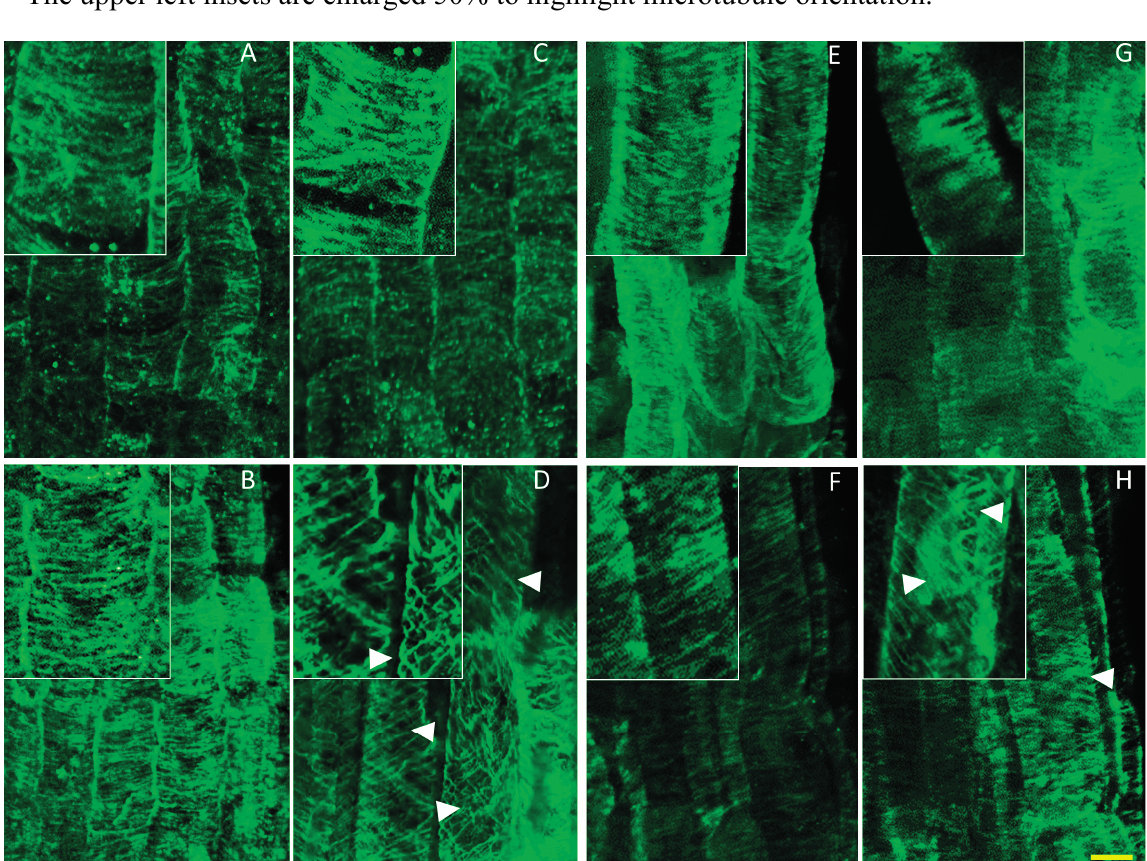
6. Potassium induces helical reorganization of cortical microtubules of nhx1nhx2nhx3nhx4 epidermal cells in the root elongation zone. Immunolabeled microtubules in WT (top) and nhx1nhx2nhx3nhx4 (bottom). Seedlings were germinated on minimal media containing 1 mM K + for three days, then transferred to plates with two concentrations of Taxol and grown for an additional five days before fixation. Normal microtubule orientation is observed in WT ( A ) and nhx1nhx2nhx3nhx4 ( B ) when grown on media containing 1 mM K + . WT seedlings grown on 30 mM K + displayed normally-orientated microtubules ( C ), whereas 30 mM K + induced a helical orientation of the cortical microtubules in nhx1nhx2nhx3nhx4 ( D ). In the presence of 1 mM K + and 0.5 µM Taxol, both WT ( E ) and nhx1nhx2nhx3nhx4 ( F ) display characteristic bundling of cortical microtubules. Whereas 30 mM K + had no effect on microtubule orientation in WT grown with 0.5 µM Taxol ( G ), nhx1nhx2nhx3nhx4 seedlings grown with 30 mM K + and 0.5 µM Taxol ( H ) exhibited a helical microtubule organization similar to that seen when grown with just 30 mM K + . Arrows point to helically-oriented microtubules. The bar is 10 μ M. The upper left insets are enlarged 50% to highlight microtubule